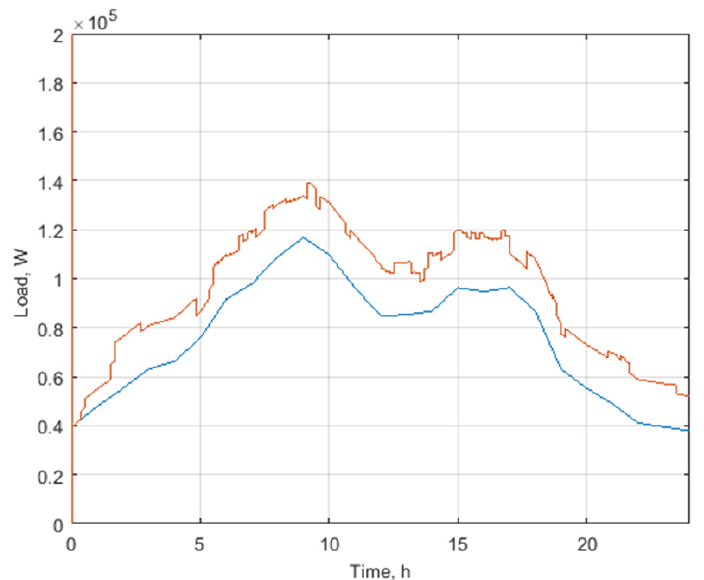
Figure 12. Power consumption over twenty-four hours based on uncontrolled charging. (Brown— general demand; blue—CLN load).